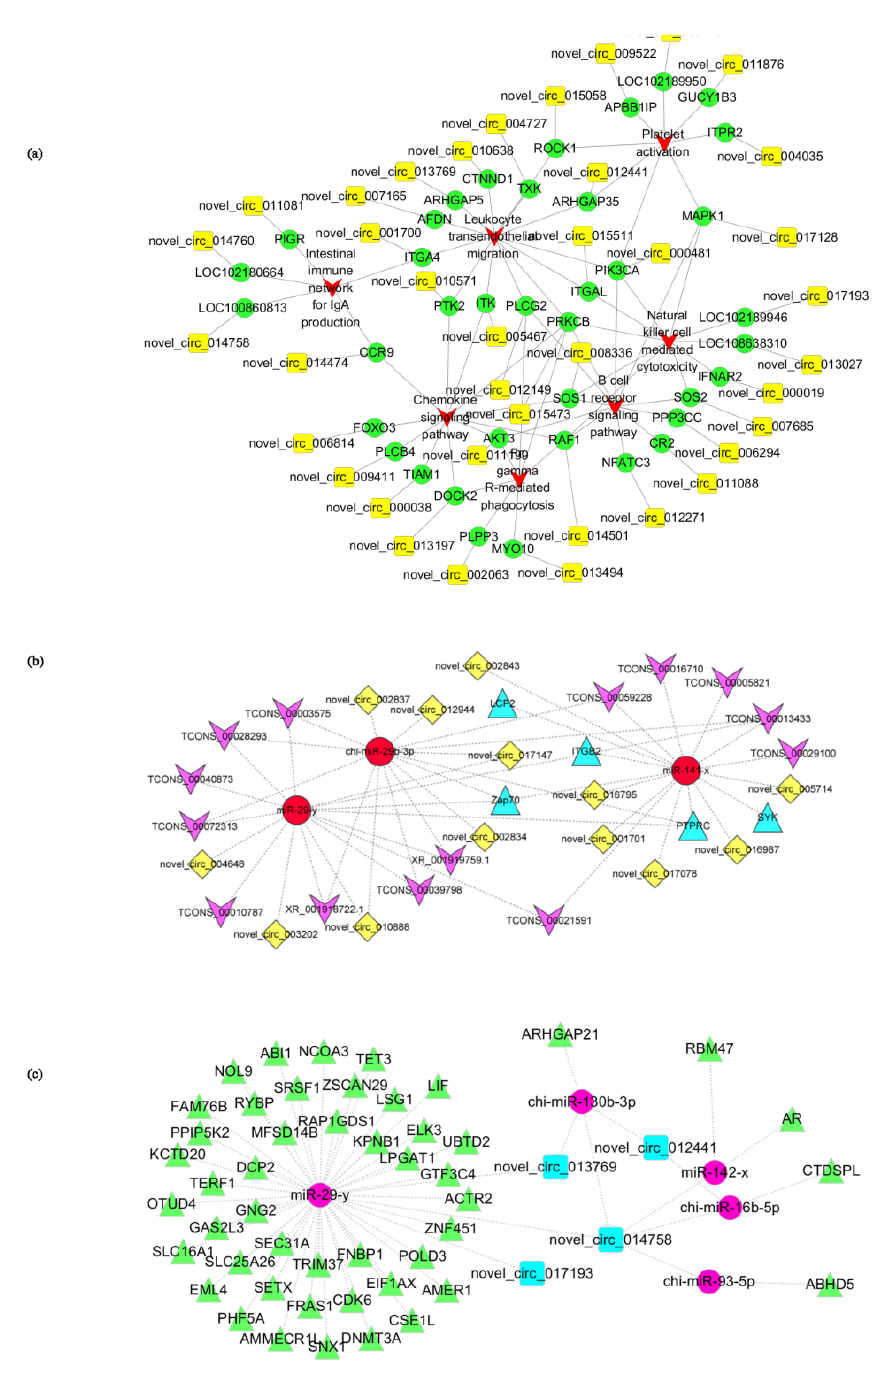
Figure 7. Network analysis. ( a ) Network analysis of immune-related pathways. The red V repre- sents KEGG pathway, the green circle represents gene, and the yellow square represents circRNA. ( b ) Regulatory network of the ceRNA-miRNA-core gene. Red circles represent miRNA, rose arrows represent lncRNA, blue triangles represent core genes, and yellow rhombuses represent circRNAs. ( c ) Immune-related circRNA-miRNA-mRNA network. Red circles represent miRNA, blue squares represent circRNA, and green triangles represent mRNA.